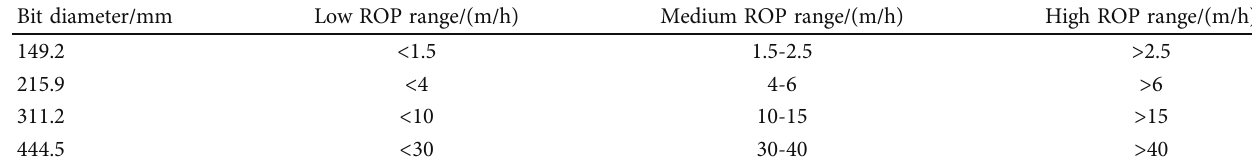
Table 1: Classi fi cation of ROP corresponding to di ff erent bit sizes in an oil fi eld in Xinjiang working area.